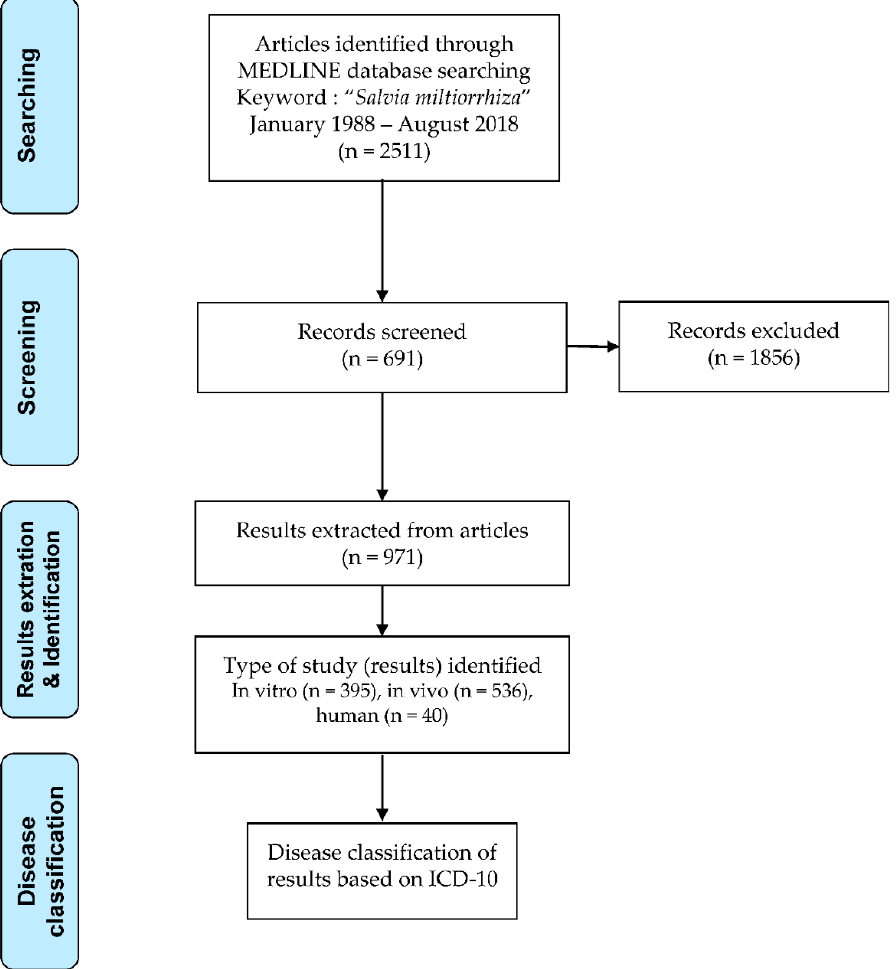
Figure 1. Flowchart of research article selection, result extraction, and classification.